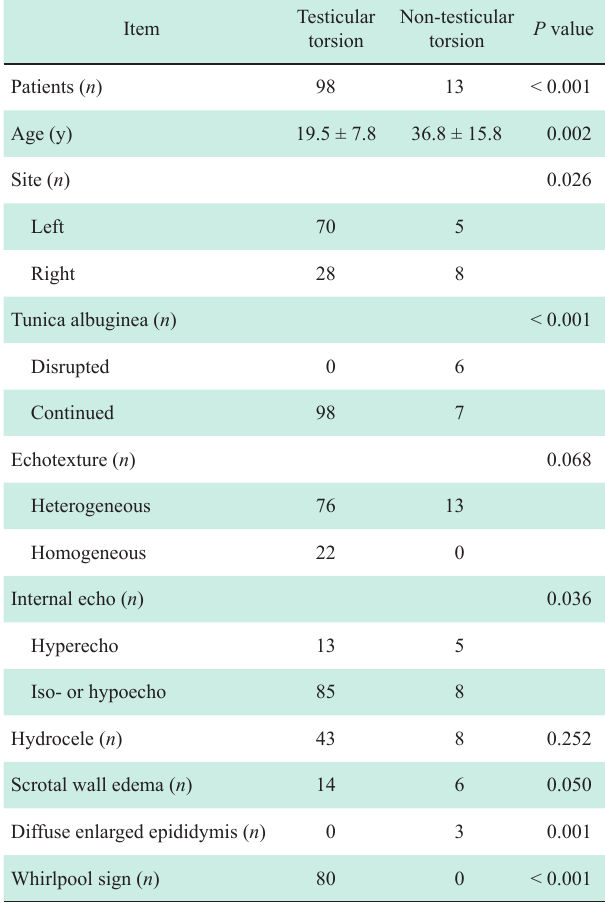
Table 2 Ultrasound parameters for 111 patients with absence of blood flow in the testis with different